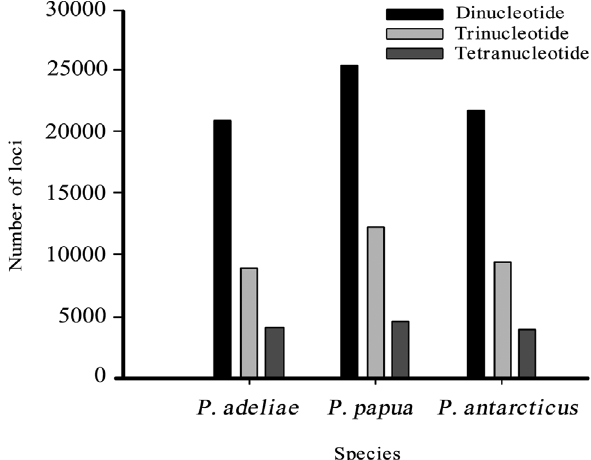
Figure 1 - Numbers of identified dinucleotide (black), trinucleotide (light gray) and tetranucleotide (dark gray) microsatellite repeat loci, for P. adeliae, P. papua and P. antarcticus